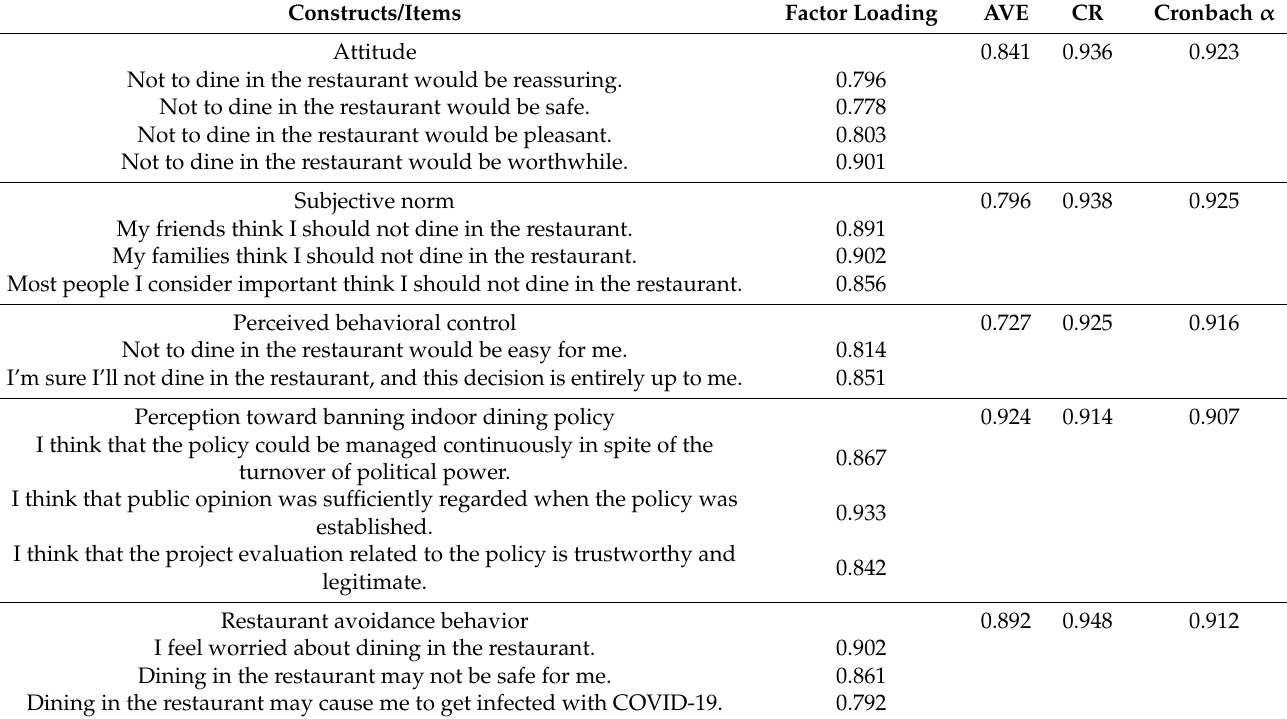
Table 2. Reliability and validity